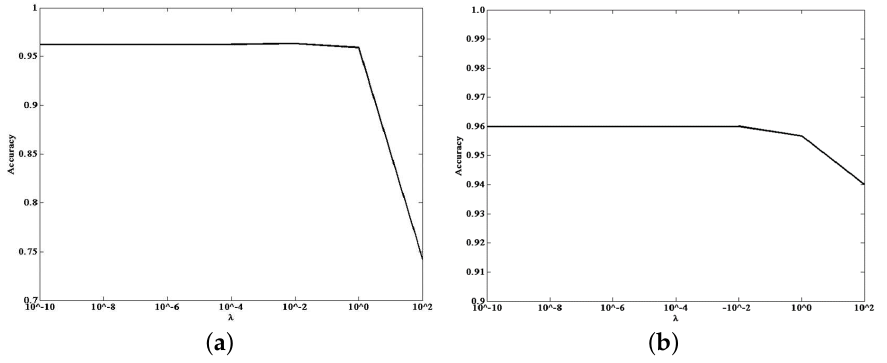
Figure 4. The influence of the target value λ target of HIHT on the recognition performance. ( a ) Ex- tended YaleB. ( b ) AR Face.